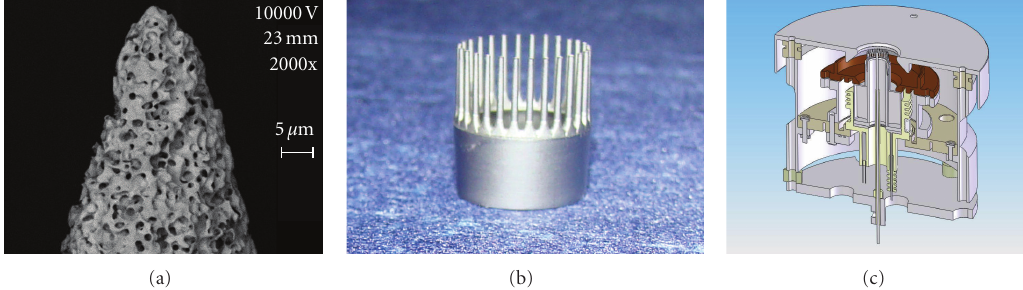
Figure 8: Porous tungsten FEEP thruster: porous tip, crown multitip emitter and thruster design.